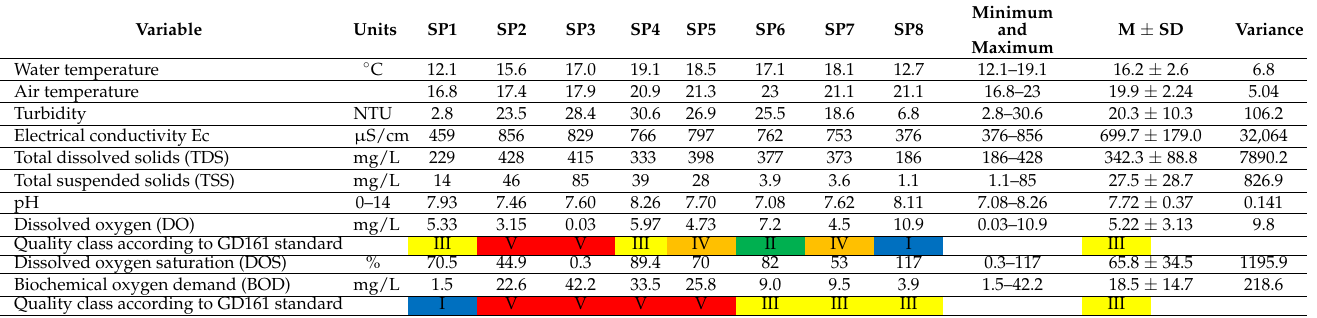
Table 4. Summary statistics of environmental variables for the eight sampling sites, showing the mean and the standard deviation for each physicochemical parameters and their ecological status according to standard